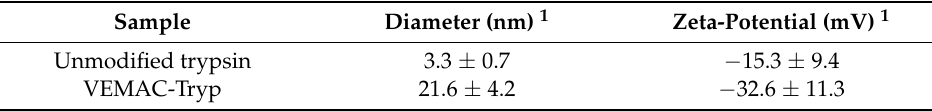
Table 2. Diameter and zeta potential of trypsin before and after vinylmethylether-maleic acid copolymer (VEMAC)